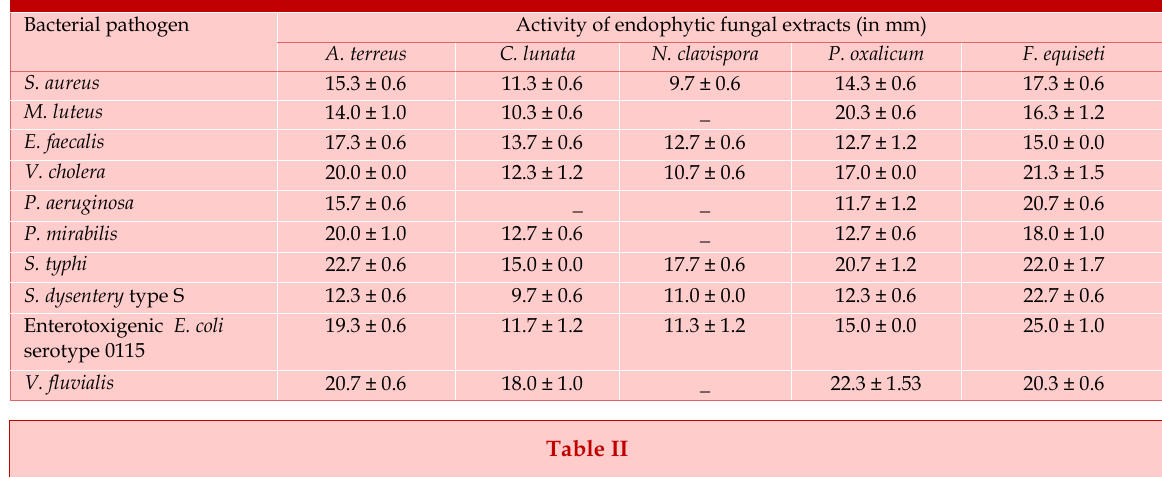
Antibacterial activity of endophytic fungi isolated from mangrove roots Bacterial pathogen Activity of endophytic fungal extracts (in